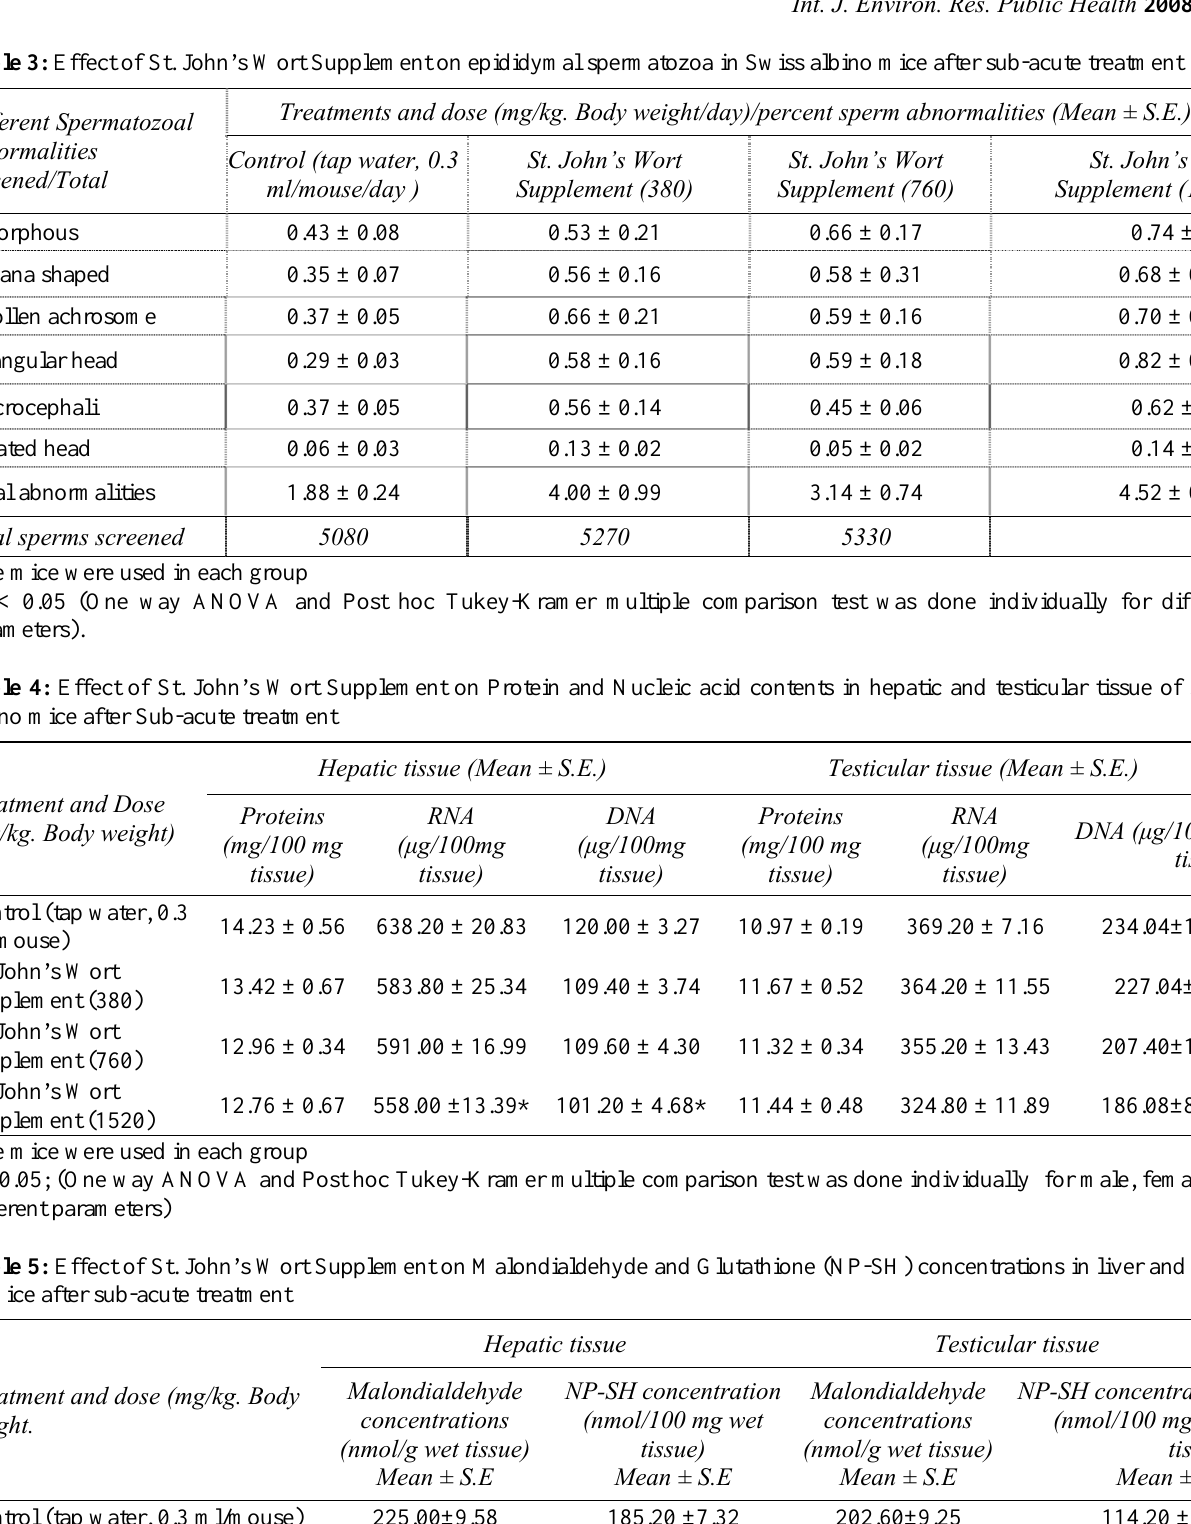
Treatment and dose (mg/kg.